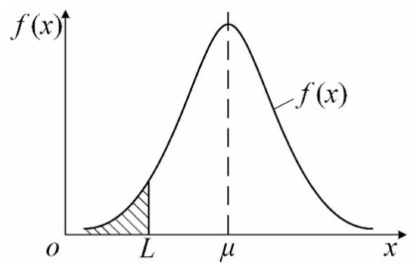
Figure 2. Simplified model of the stress–strength